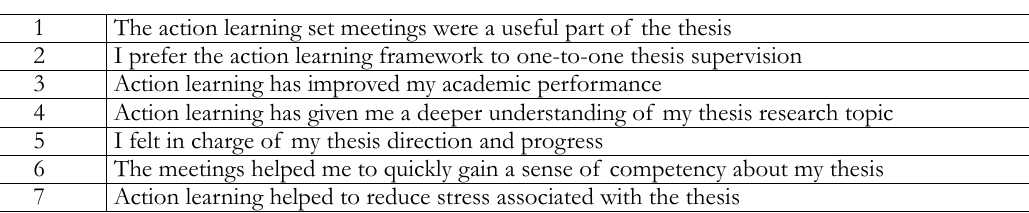
Table 1. End of project student perception survey part a